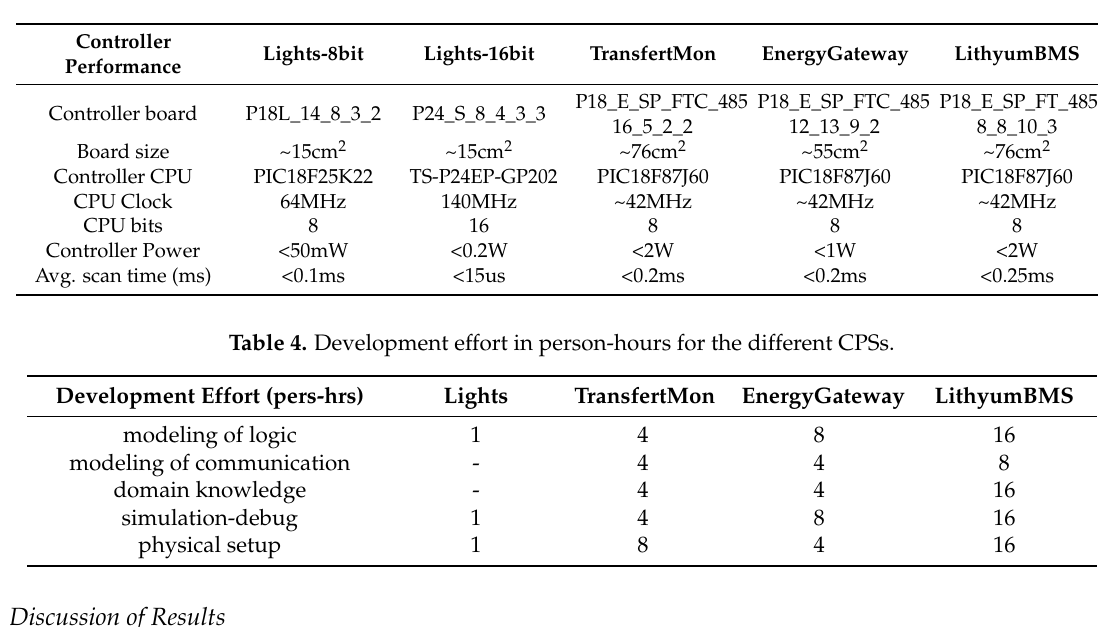
Table 3. Controller Performance for the different CPSs.